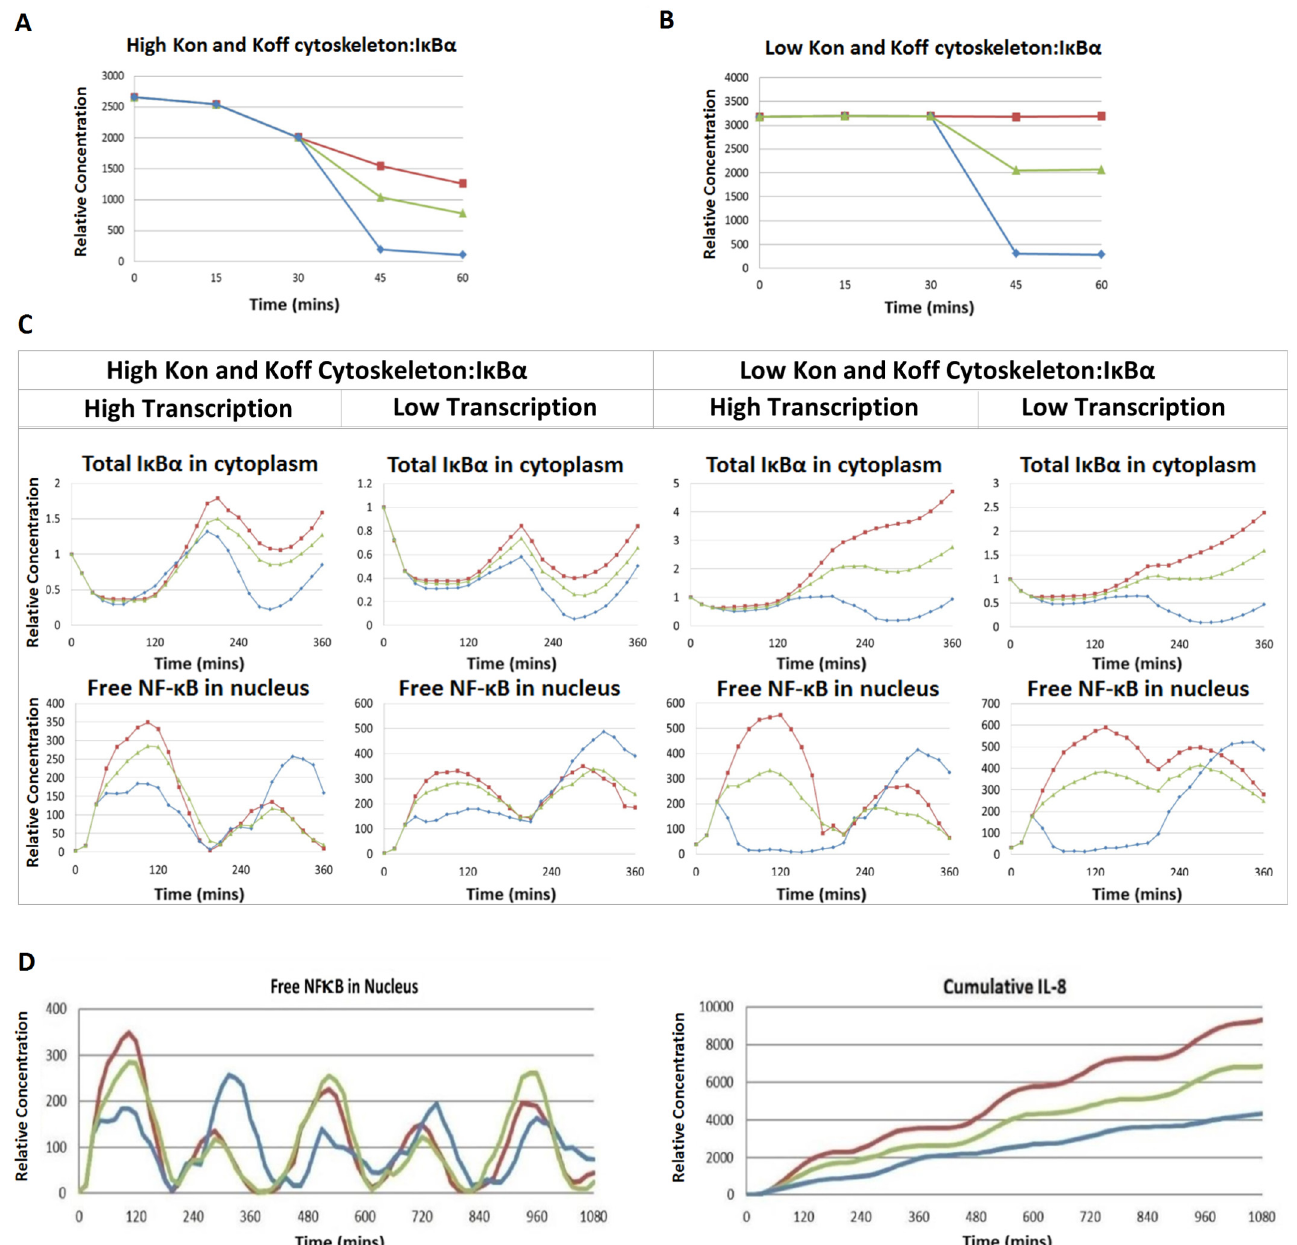
Fig 3. IL-1-induced release of I κ B α from the cytoskeleton is characterized by high Kon /Koff rates. A, B. Simulation of levels of I κ B α bound to the cytoskeleton during IL-1 β stimulation under various settings. Release from the cytoskeleton was governed by Kon and Koff rates, adjusted to be high (A) or low (B) at the same Ka, with 2/3 of I κ B α bound to the cytoskeleton at time = 0. Inhibitor release was set at 3 levels passive release only (Red), or release of 40 – 50% (Green) or of 90 – 100% (Blue). The model including high Kon and Koff rates fits best with in vitro data seen in Fig 2C. A. p < 0.05, passive vs 40 – 50% release, p < 0.005 passive vs 90 – 100% release. B. p < 0.0005 passive vs 40 – 50% and 90 – 100% release. C. Predicted levels of I κ B α and nuclear NF- κ B using simulation settings in A and B at 3 levels of release as in A and B, and comparing two levels of transcriptional response. Simulations using high Kon and Koff rates and high transcription rates result in a behaviour that fits the in vitro data. D. Simulation output over 18 hours using the best-fit model (high Kon and Koff rates, high transcription rates) and 3 levels of inhibitor release, as in A and C, show nuclear NF- κ B (left graph) and IL-8 gene activity (right graph). Simulations predict that all 3 levels of I κ B α release are functional over multiple cycles of nuclear translocation (left), and prolonged inflammatory responses (right). IL-8 accumulation at 1080 min p < 0.005 passive vs 40 – 50% release, p < 0.0005 passive vs. 90 – 100% release. Graphs in A-D show an average of 3 simulations for each condition.